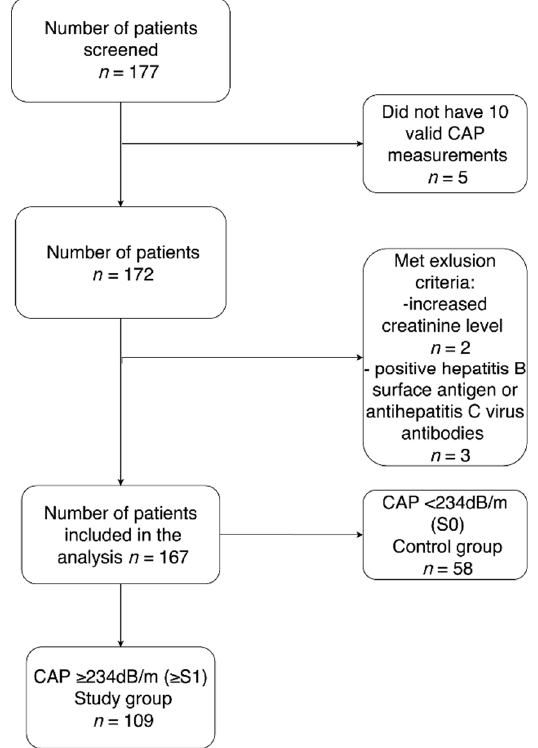
Figure 1. The study flow chart.